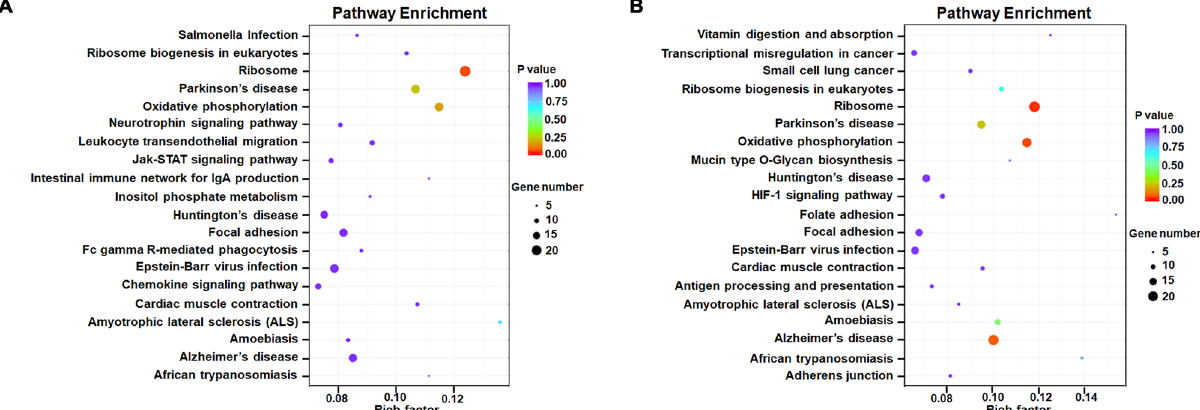
Figure 3. Pathway enrichment of lncRNAs co-expressed genes derived from PC12. ( A ) KEGG pathway analysis of the co-expressed genes of the annotated lncRNAs; ( B ) KEGG pathway analysis of the co-expressed genes of the novel lncRNAs. The horizontal axis represents enrichment factor and the vertical axis represents pathway. Different colors represent different adjusted p values. From purple to red, the adjusted p value changes from large to small and the degree of enrichment becomes more and more significant. The size of the dot represents the number of genes enriched into this